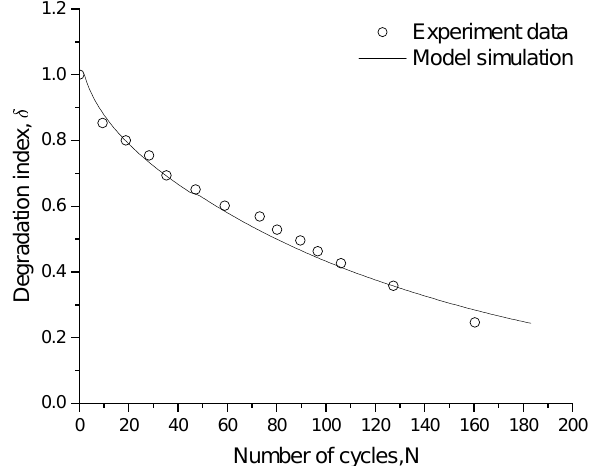
Figure 14. Experimental-numerical comparison of the degradation index evolution for soft marine